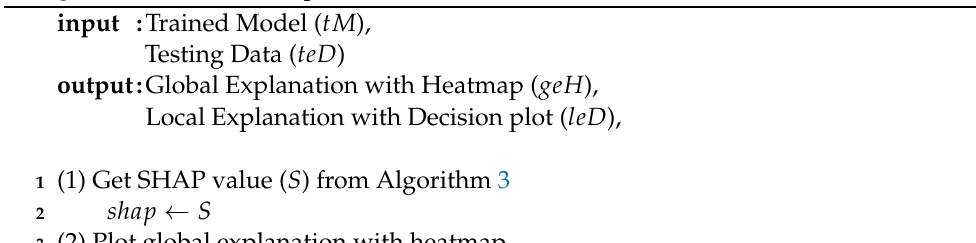
Algorithm 4: Models Explanation with